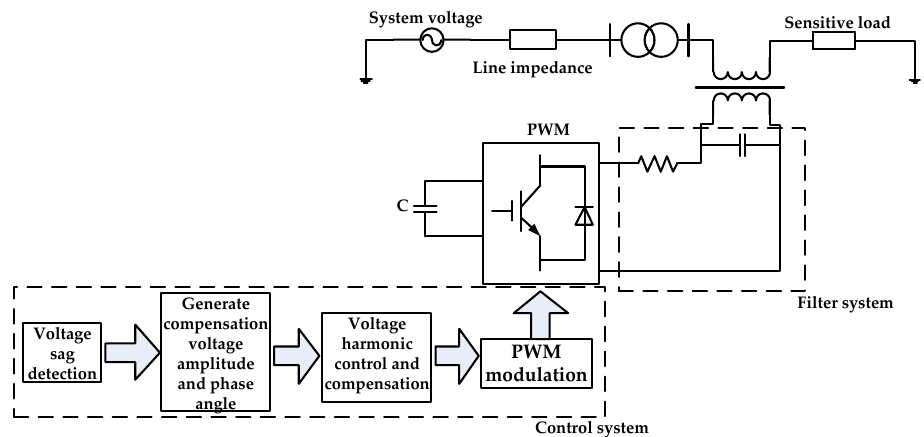
Figure 1. Dynamic voltage restorer (DVR) compensation schematic.